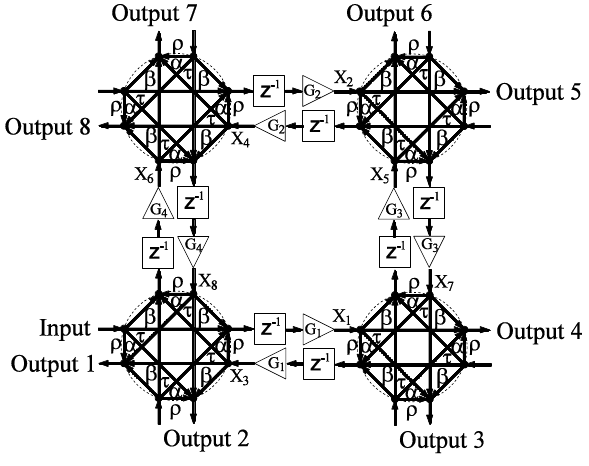
Figure 3. Network diagram of structure III. Transmitted,  , reflected,  , right- directed,  , and left-directed,  , coupler coefficient components. Photonic channelizer enabled by 4 four-port couplers, ....)3,2,1(  iG represent gain (triangles), 1  Z represent i unit delay (blocks), and X are internal states. Arrows indicate signal i